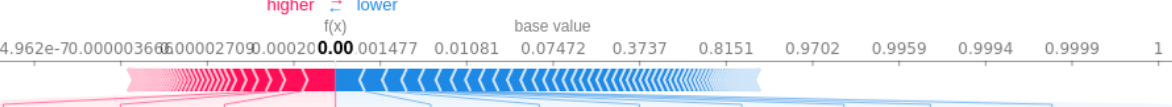
Figure 5. Local explainability of a specific patient outcome prediction.